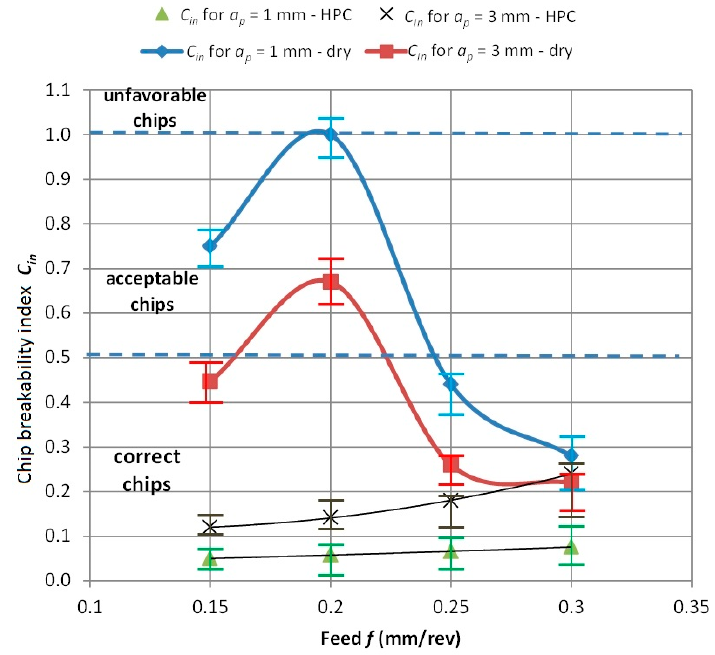
Figure 9. Relationship between the chip breaking index ( C in ) and the feed ( f ).